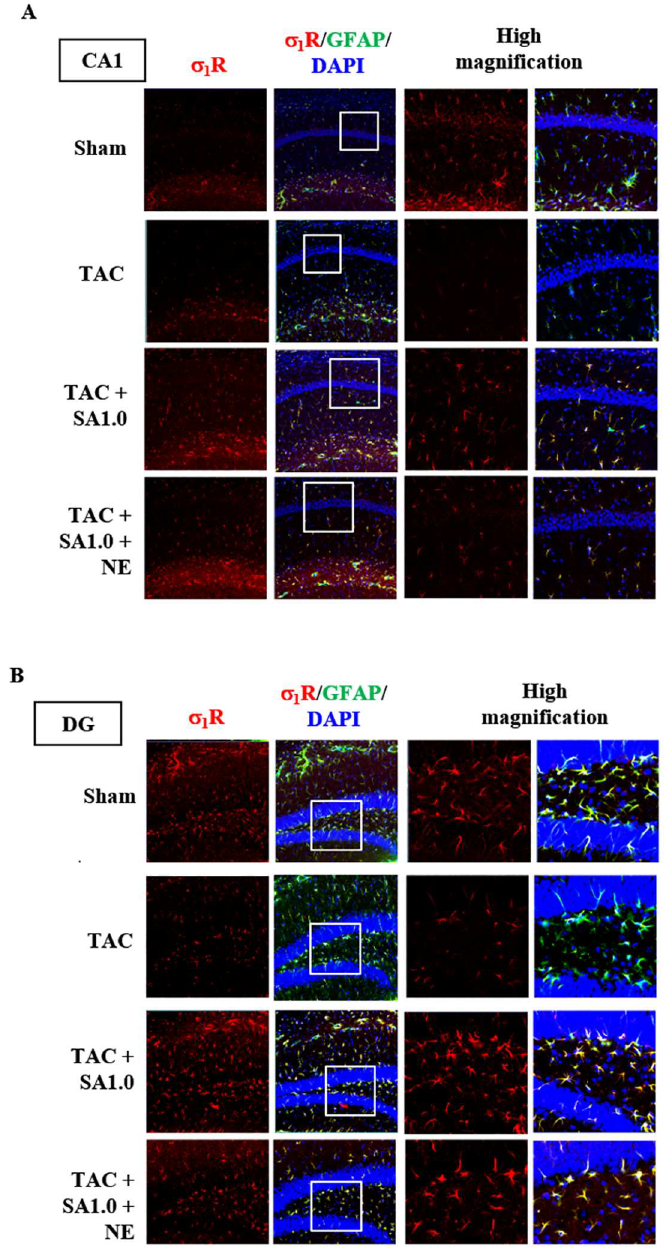
Fig 3. Effect of SA4503 treatment on σ 1 R expression in hippocampal astrocytes. A: Immunofluorescence showinglocalization of σ 1 R (red) with the astrocyte marker GFAP (green) and DAPI (blue) in the CA1 region 6 weeks after TAC surgery with or without drug treatment for the last 4 weeks. B: Immunofluorescence showinglocalization of σ 1 R (red) with GFAP (green) and DAPI (blue) in DG 6 weeks after TAC surgery with or without drug treatment for last 4 weeks. TAC mice were treated with SA4503 (0.1, 0.5 or 1.0 mg/kg) or SA4503 (1.0 mg/kg) plus NE-100 (1.0 mg/kg), as indicated. Boxed regions in all panels are magnifiedin adjacent right-handpanels.